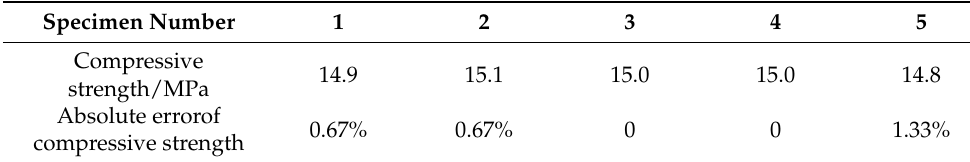
Table 11. Test results of compressive strength of coal type.